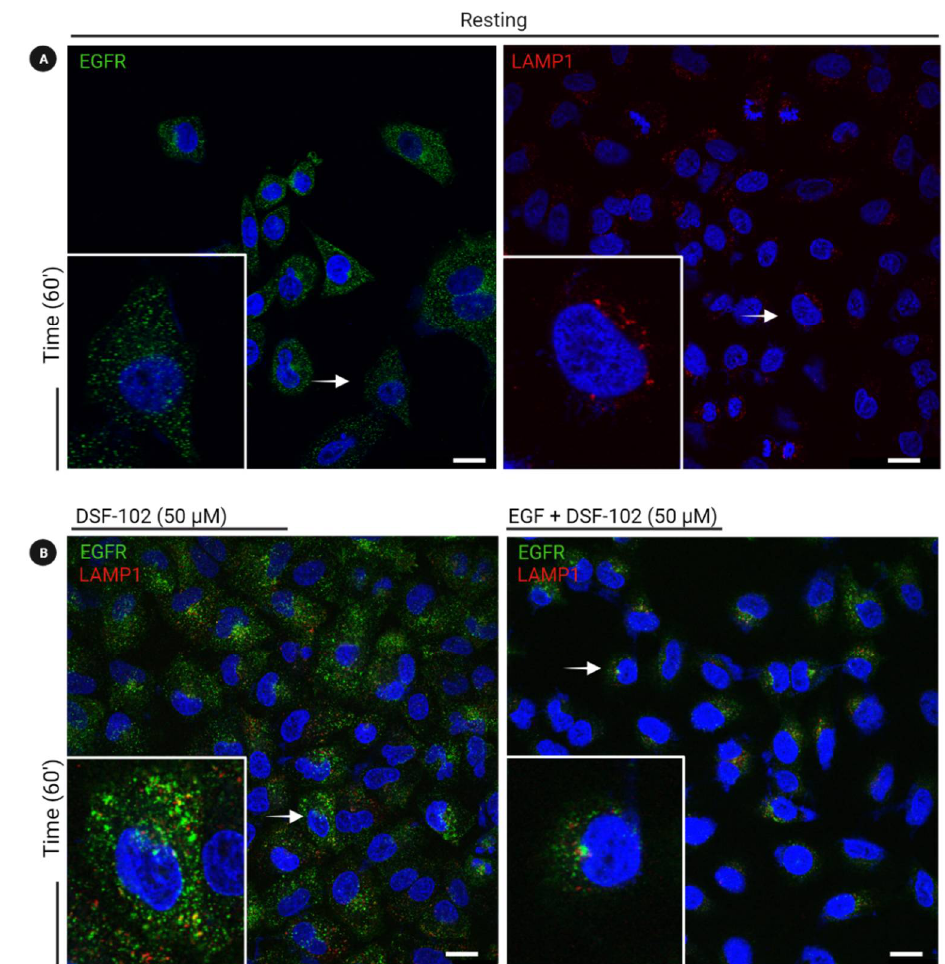
Figure 7. Flow cytometry analysis of DSF-102 activity on EGFR signaling. ( A ) p44/42 ERK and ( B ) p38 MAPK activation at 30 and 60 min following the co-administration of DSF-102 (50 μM) and EGF (100 ng/mL). Samples treated with only EGF or DSF-102 , and resting cells were used as con-